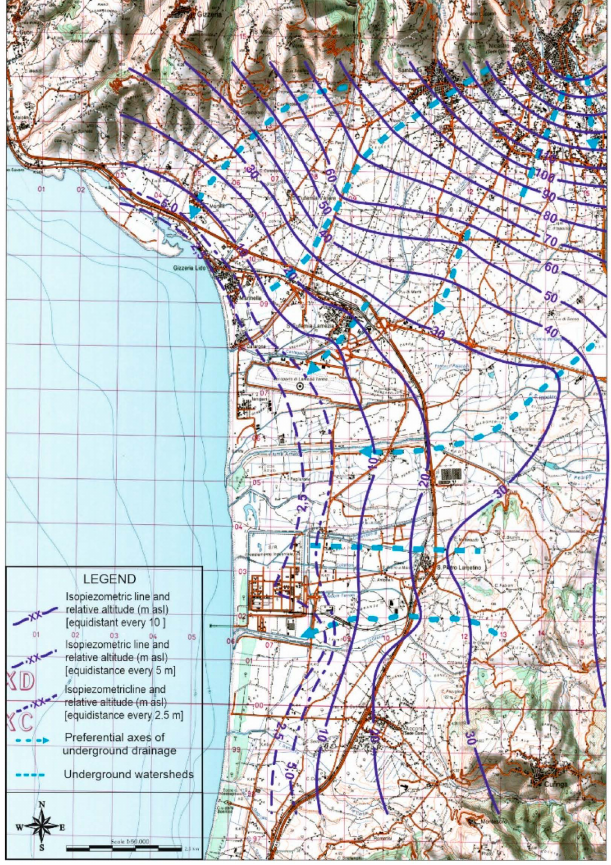
Figure 5. Piezometric Map of the Surface Aquifer of the S. E. Lamezia Plain (Modified) [14]. The analysis of the piezometric morphology shows a recharge area in the northern sector and drainage areas in the middle and coastal strip of the plain. There are also pref- erential drainage axes, with the primary one being roughly located in the center of the